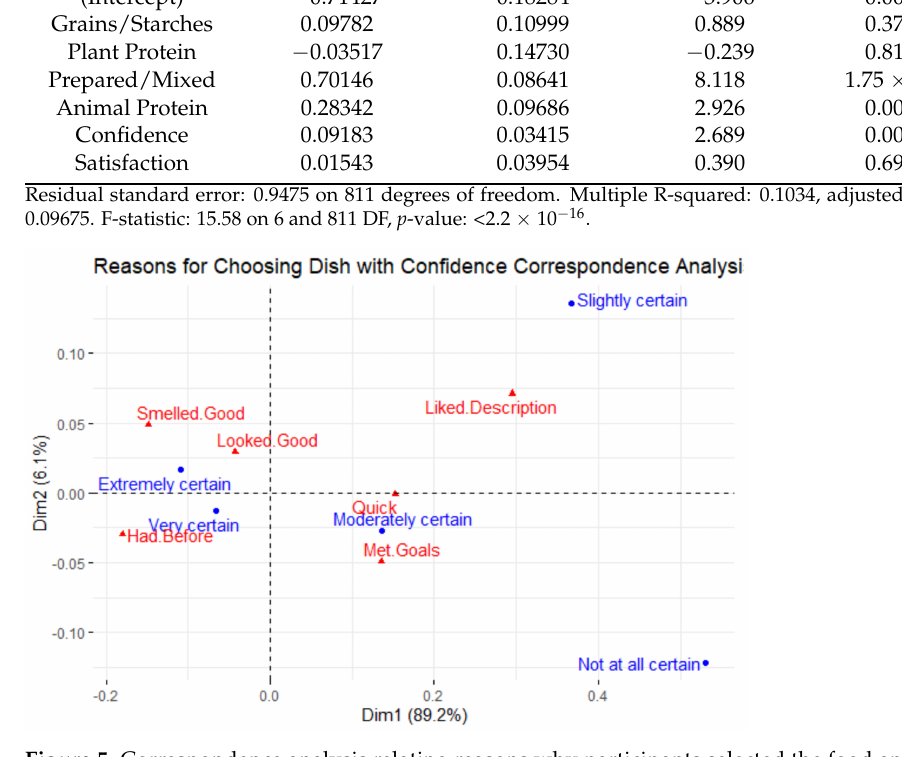
Figure 5. Correspondence analysis relating reasons why participants selected the food and the level of confidence they had in liking it before taking the item.